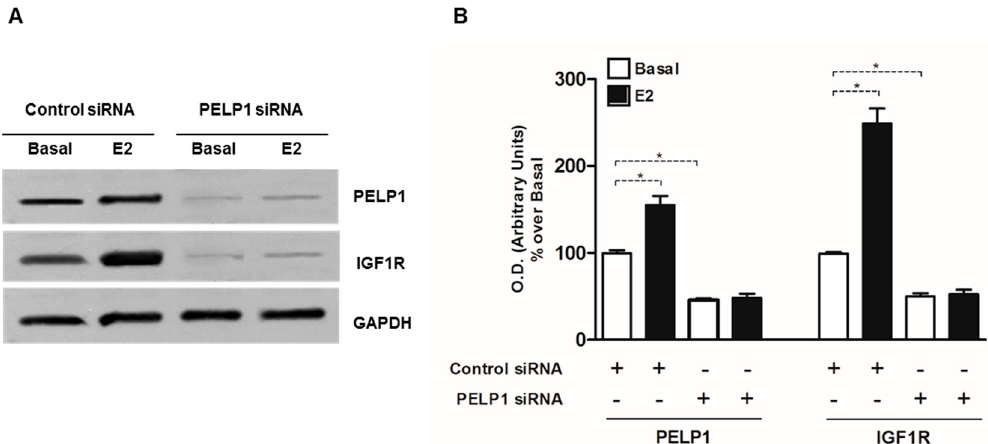
Figure 4. PELP1 knockdown decreases IGF1R expression in H295R cells. ( A ) H295R cells were transfected with PELP1 siRNA or a non-targeting siRNA (control siRNA) for 24 h. After transfection cells were treated for 24 h with E2 (100 nM). Western blot analyses of PELP1 and IGF1R were performed on 50 µ g of total protein. Results are representative of three independent experiments. GAPDH was used as a loading control; ( B ) The graph represents mean of PELP1 and IGF1R optical densities (O.D.) from three independent experiments with similar results normalized to GAPDH content (* p < 0.001 compared to untreated control sample (Basal) assumed as 100).